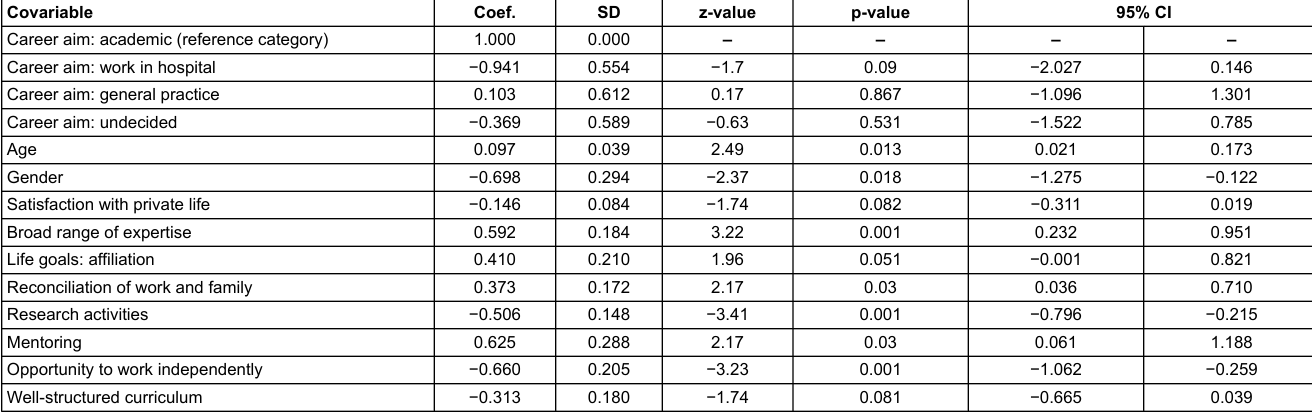
Table S1: Logistic regression including all factors showing a significant difference between GIM and SUB residents. Response: probability of choosing GIM over SUB; n = 327; likelihood ratio for whole model: 94.50 on 13 df (p <0.005); pseudo R 2 = 0.23. Covariable